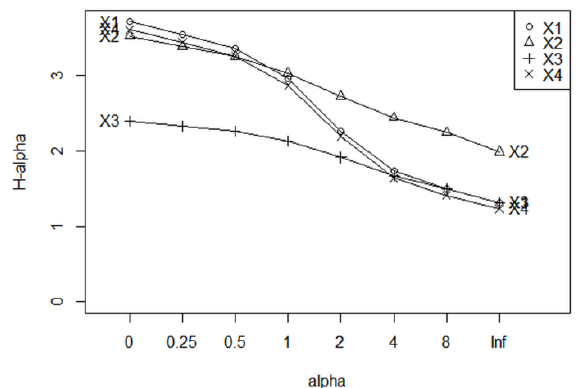
F IGURE 2: Rényi diversity profiles for separate habitats; alpha = 0 indicates species richness; marked points along each profile represent randomly selected sampling points for each habitat: X1- Crop fields, X2-Fallow farmland, X3-Forest core, X4-Forest edge. richness of annuals (Potts et al. 2003) and overall floral diversity (Banaszak 1996). Our results finding agree with